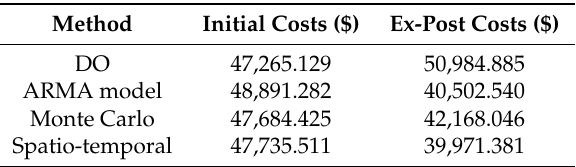
Table 3. The costs of methods.